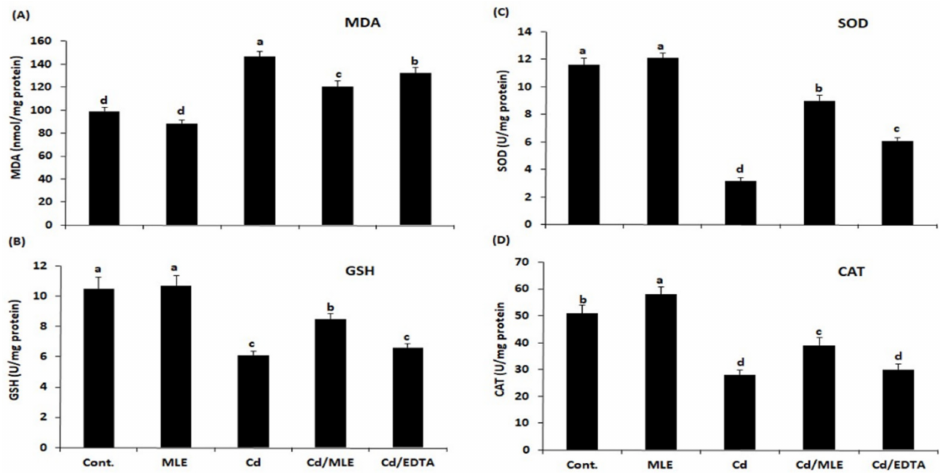
Figure 3. Hepatic oxidative stress parameters in the different groups under study. ( A ) Malondialde- hyde (MDA), ( B ) reduced glutathione (GSH), ( C , D ) superoxide dismutase (SOD), and catalase (CAT) activities. Tukey pairwise comparison; means that do not share a letter are significantly